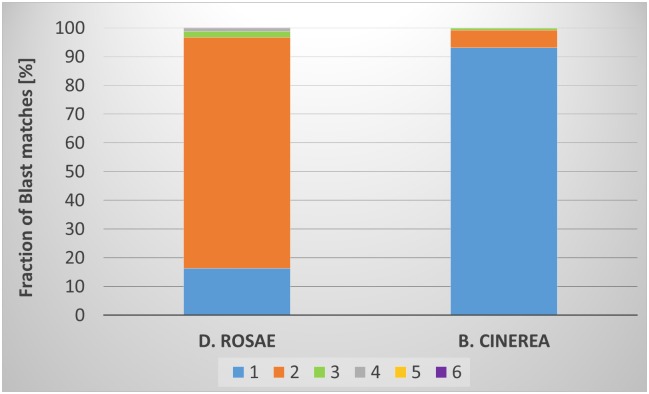
Comparison of the percentage of Blastp matches with different numbers of matches to the same reference sequence between D. rosae and B. cinerea.The portion of the M. Brunnea proteome that had no second match in a Blast (E-value cutoff e-100) of the proteome against itself was the reference for the Blastp search. The cutoff for the Blastp of the related species was set to e-100. The different colors refer to the number of Blast matches to the same M. Brunnea reference sequence.